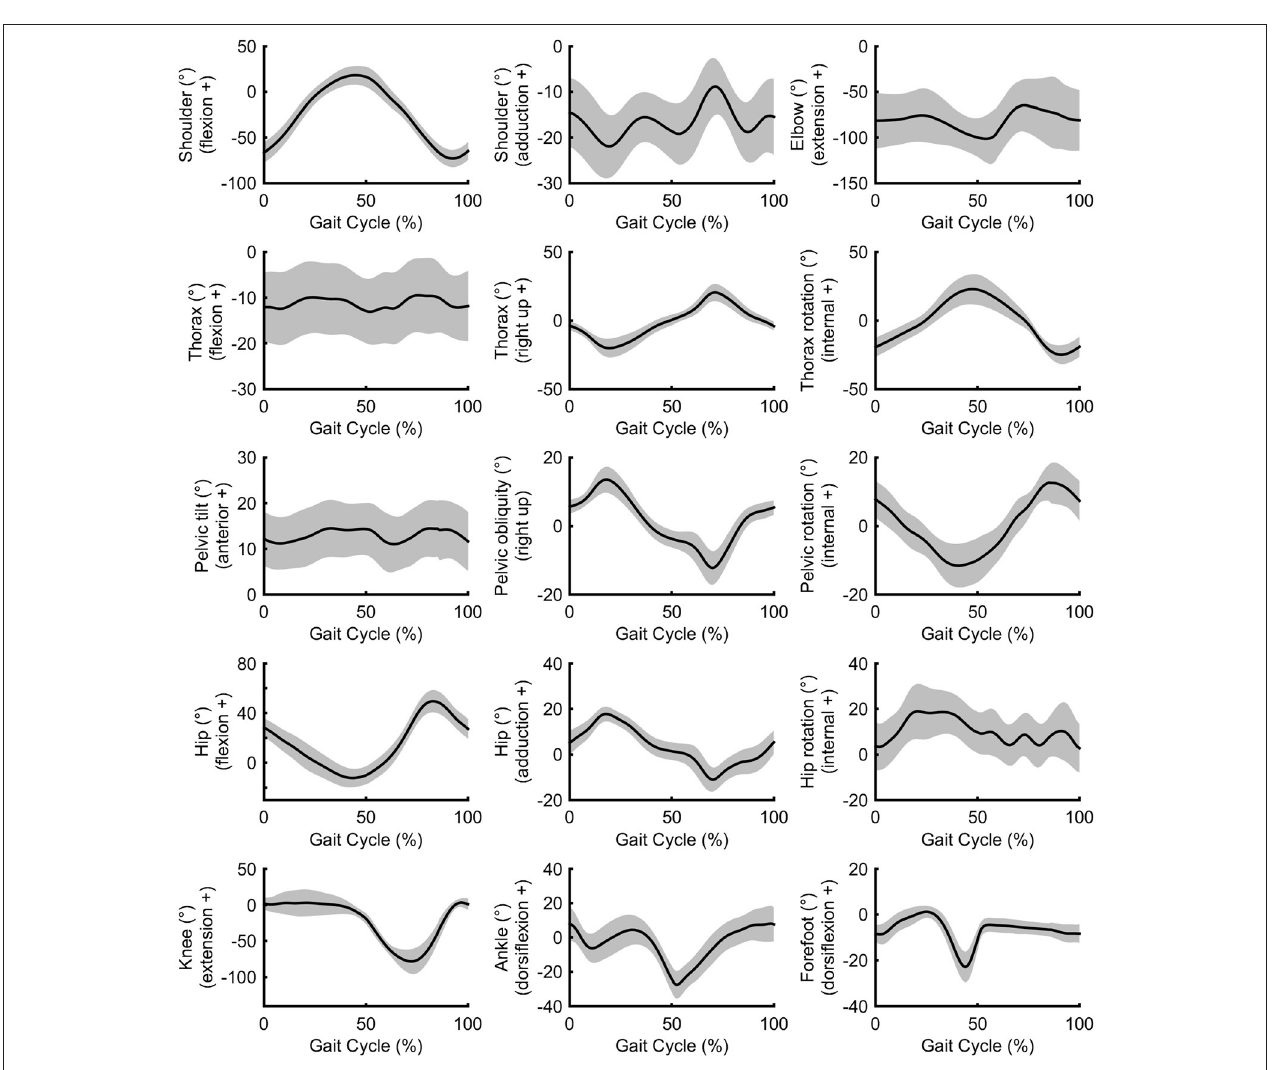
FIGURE 3 | Group mean ( ± SD) upper and lower body joint angle kinematics.